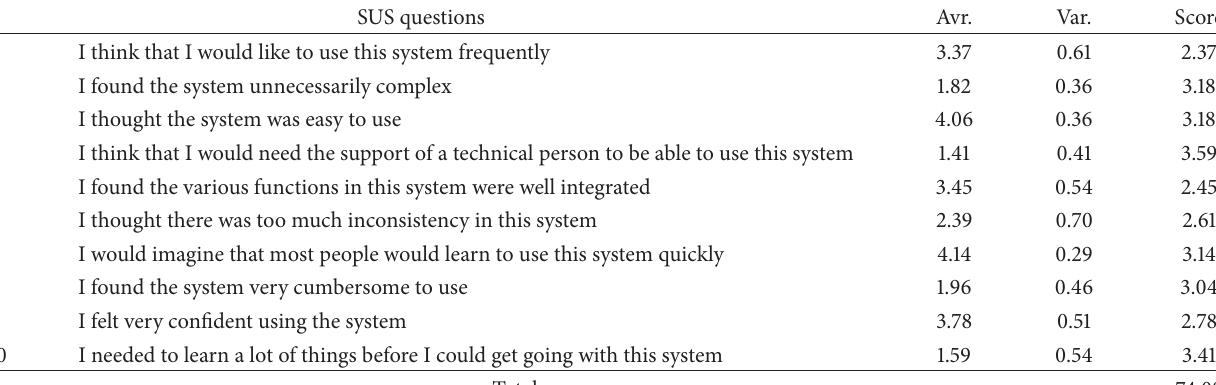
Table 3: Usability scores of the FIGA platform.